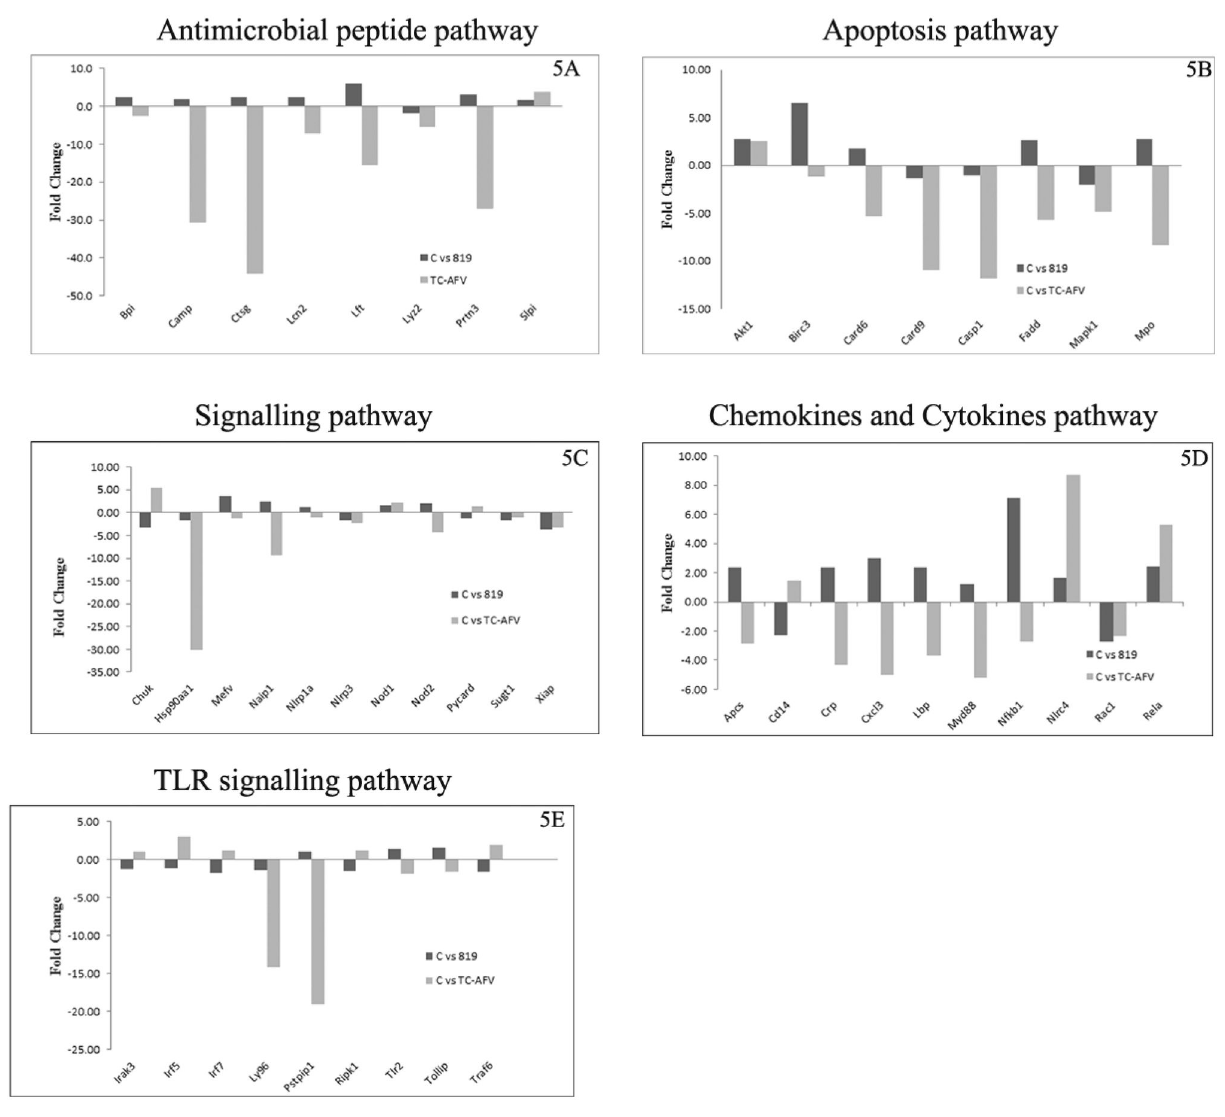
Figure 5. Comparison of host gene expression profile using Antibacterial Response PCR Arrays following infection with either S. Heidelberg transconjugant TC-AFV, which harbors mobile plasmids or the recipient isolate 819, which lack the plasmids and T4SS. Mouse macrophages were infected with TC-AFV or 819 at an MOI 1:200, for 1 hr, after which extracellular bacteria were removed and total RNA was extracted from macrophages and converted into cDNA. The pathway arrays were assessed by RT-PCR and analyzed using PCR Array Data Analysis Software (SA Biosciences). Each data point represents the means and standard deviation for 3 individual